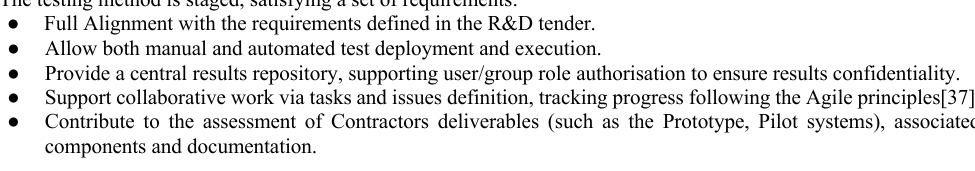
Table 1. Main areas of